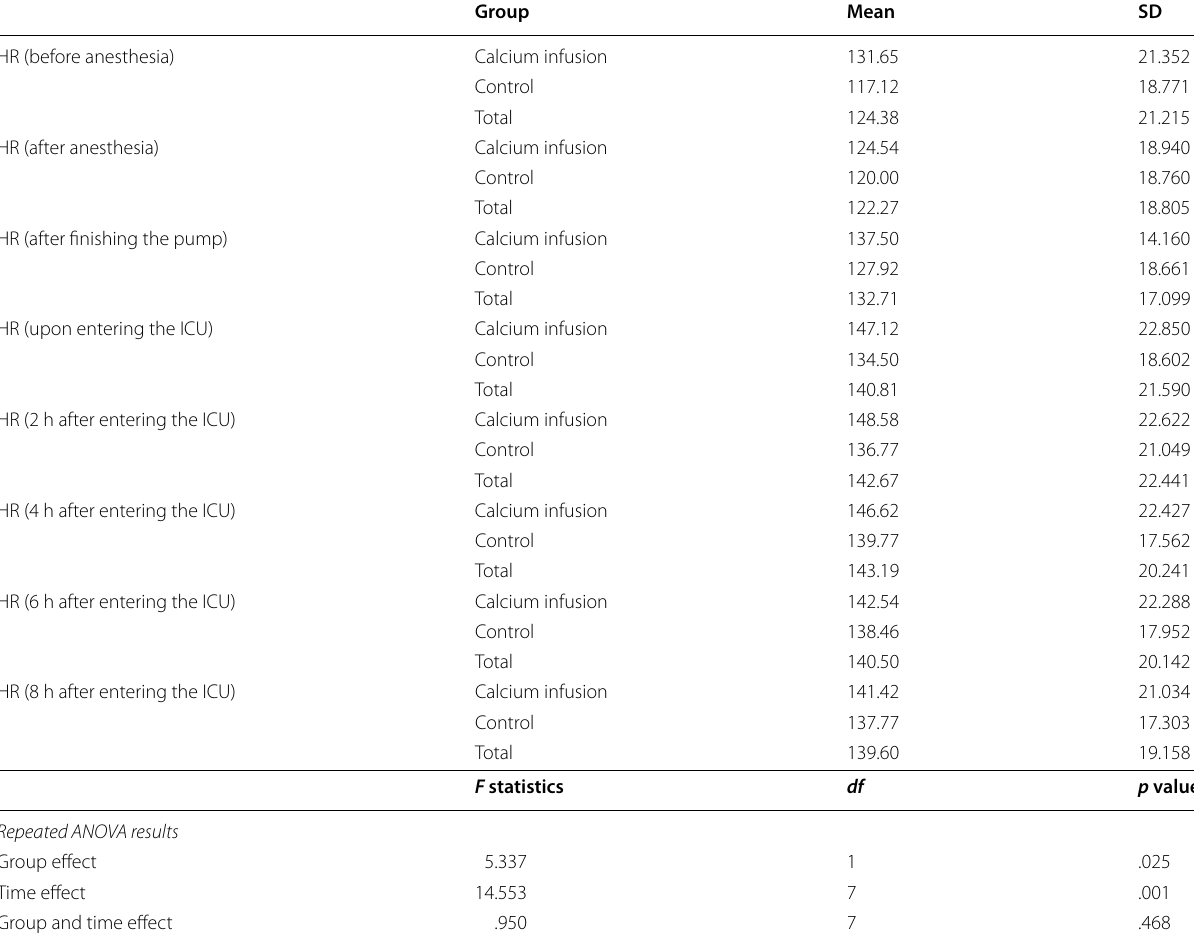
Table 5 Statistics of diastolic heart rate